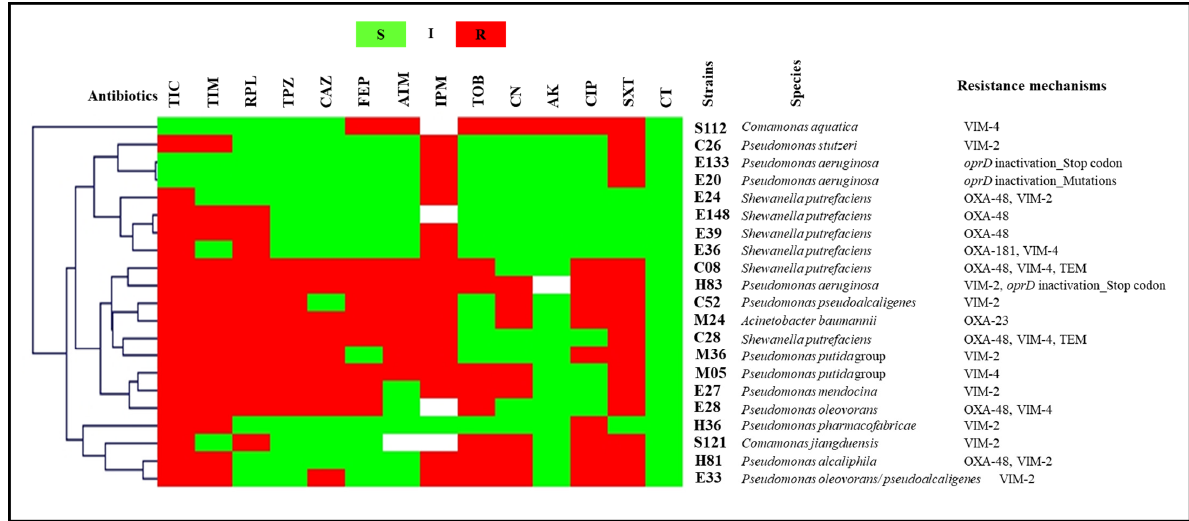
Figure 3. Antibiogram results and resistance mechanisms of glucose-non-fermenting GNB